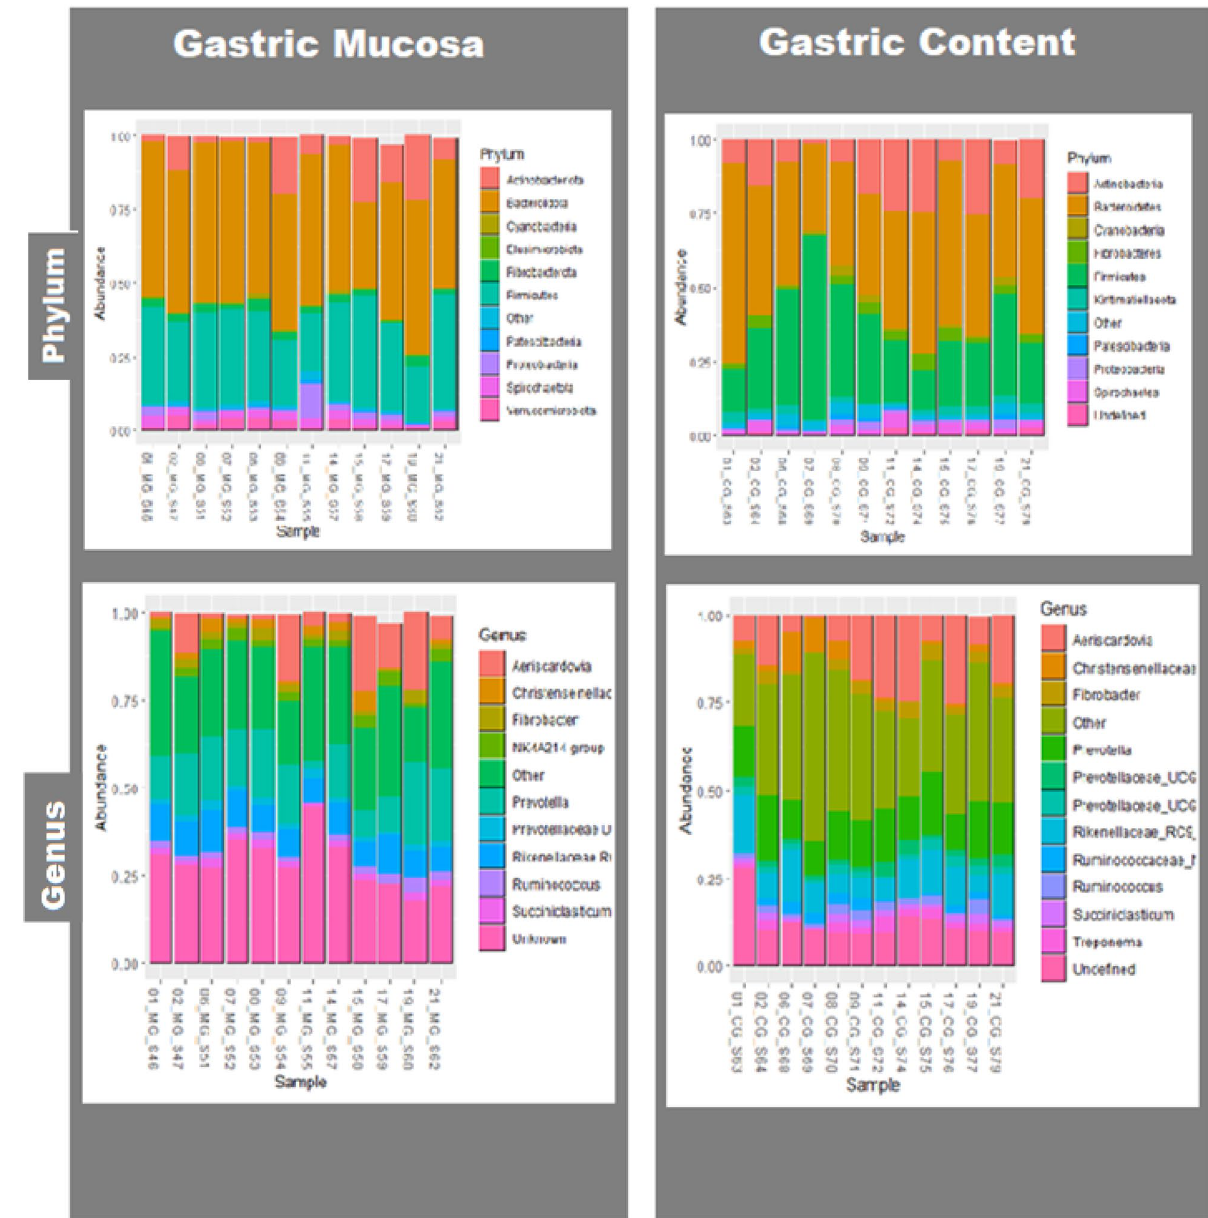
Figure 1. Relative percentage of abundance for the main taxa for phylum and genus level in resistant and susceptible